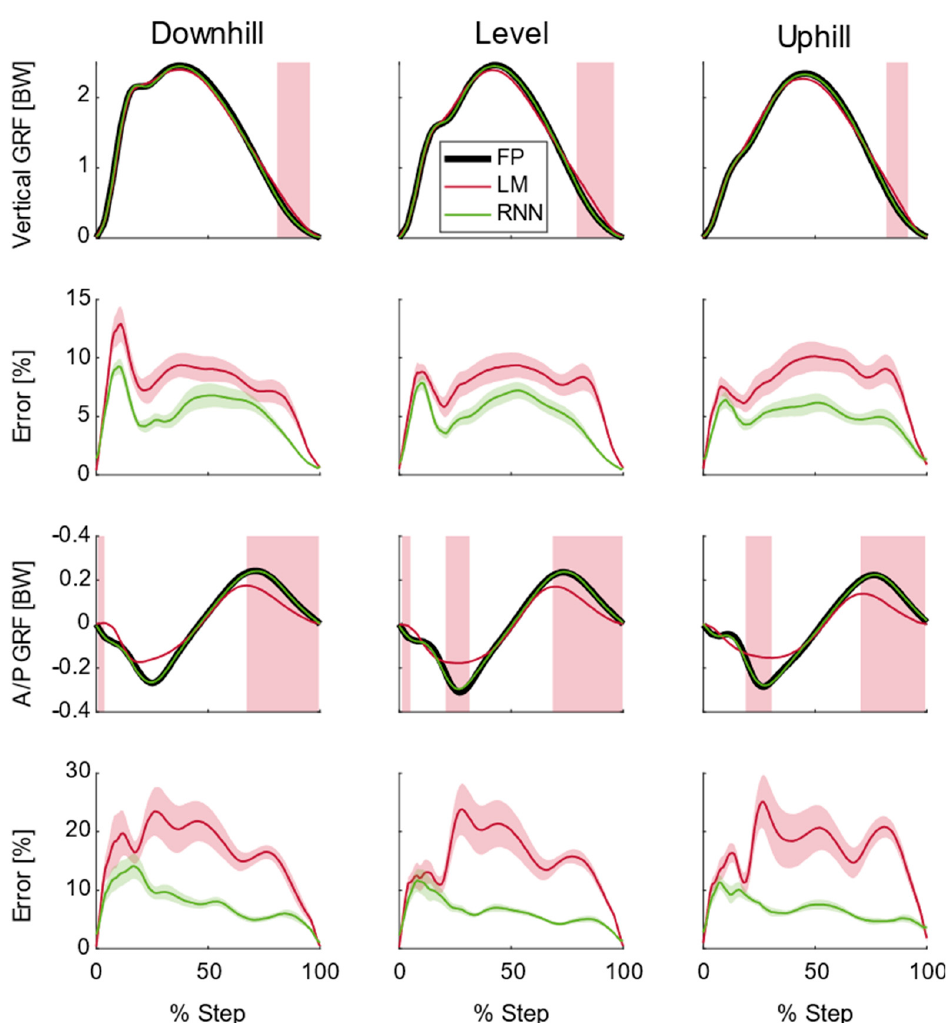
Figure 5. Average (N = 18) ground reaction forces (GRFs), model predictions, and model errors for running at 3.0 m/s. Top row shows average vertical GRF from the force platform (FP) along with average linear model (LM) and recurrent neural network (RNN) predictions. Areas shaded red are where there were significant differences between the FP and LM ( p < 0.05). There were no significant differences between the FP and the RNN ( p > 0.05). The second row shows the mean absolute percent error plus/minus one standard deviation for each model in the vertical direction. The third row shows average anterior/posterior (A/P) GRF from the FP along with LM and RNN predictions. Areas shaded red are where there were significant differences between the FP and LM ( p < 0.05). There were no significant differences between the FP and the RNN ( p > 0.05). The last row shows the mean absolute percent error plus/minus one standard deviation for each model in the A/P direction. Downhill and uphill running was performed at 6° (10.5% grade).